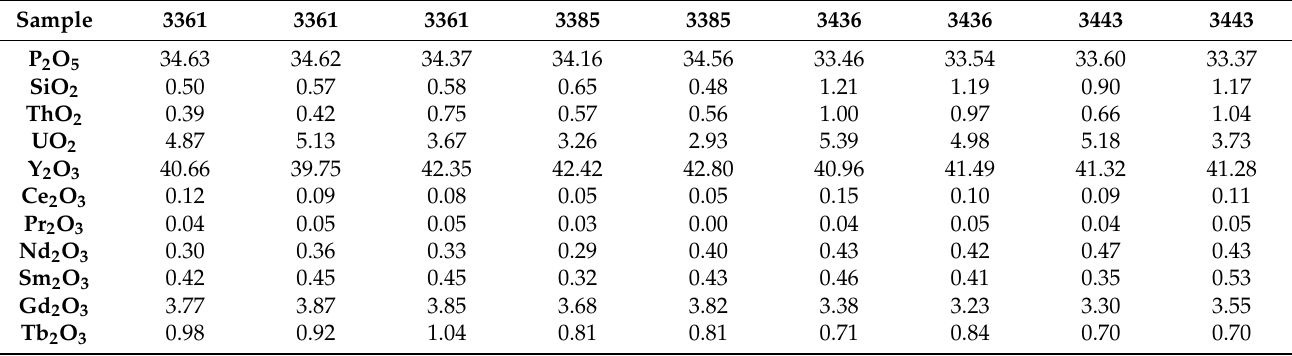
Table 3. Representative results (wt%) of electron microprobe analyses of xenotime-(Y) from Podles í . Formulae (in atoms per formula unit, apfu ) based on 4 oxygen